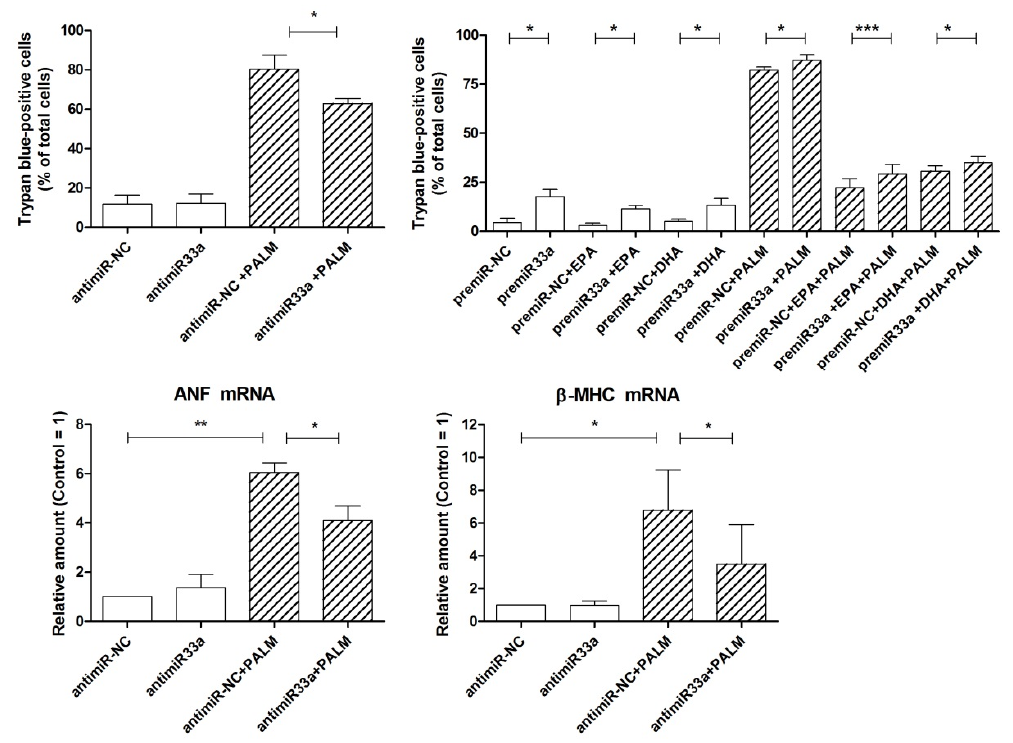
Figure 5. Effect of miR-33a on survival and hypertrophy of H9c2 cardiac cells exposed to palmitate. Top : cells were transfected for 24 h with antimiR-33a or antimiR-NC (50 nM) and premiR-33a or premiR-NC (50 nM). After a 24 h incubation with or without fatty acids, as indicated, cells were counted to assess cell viability by trypan blue exclusion test. Bottom : cells were transfected for 24 h with antimiR-33a or antimiR-NC (50 nM). After a 16 h incubation with or without palmitate, H9c2 cells were analyzed by RT-PCR for the relative amount of ANF mRNA and β-MHC mRNA, as markers of cardiac hypertrophy. Differences are indicated with *, **, *** for p < 0.05, p < 0.01 and p < 0.001, respectively.